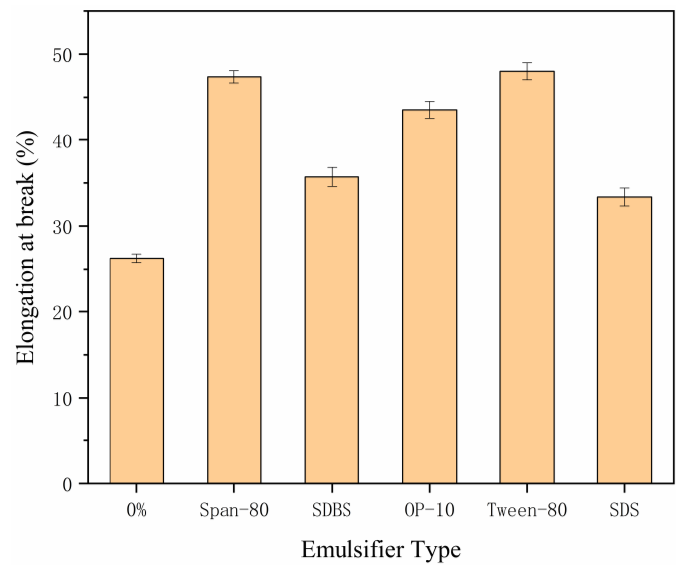
Figure 6. Effect of emulsifier on elongation at break of paint film.